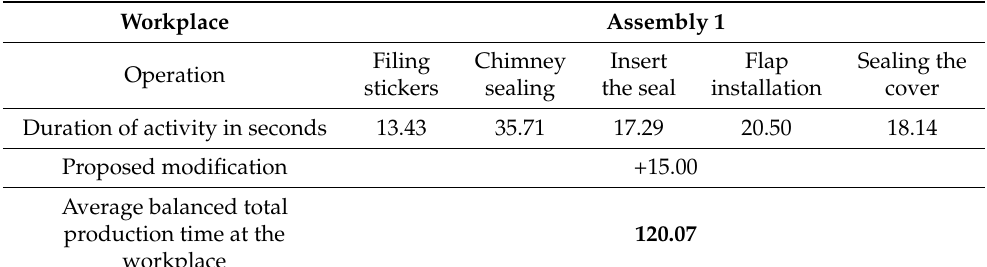
Table 7. Average balanced total production time at the workplace Assembly 1.